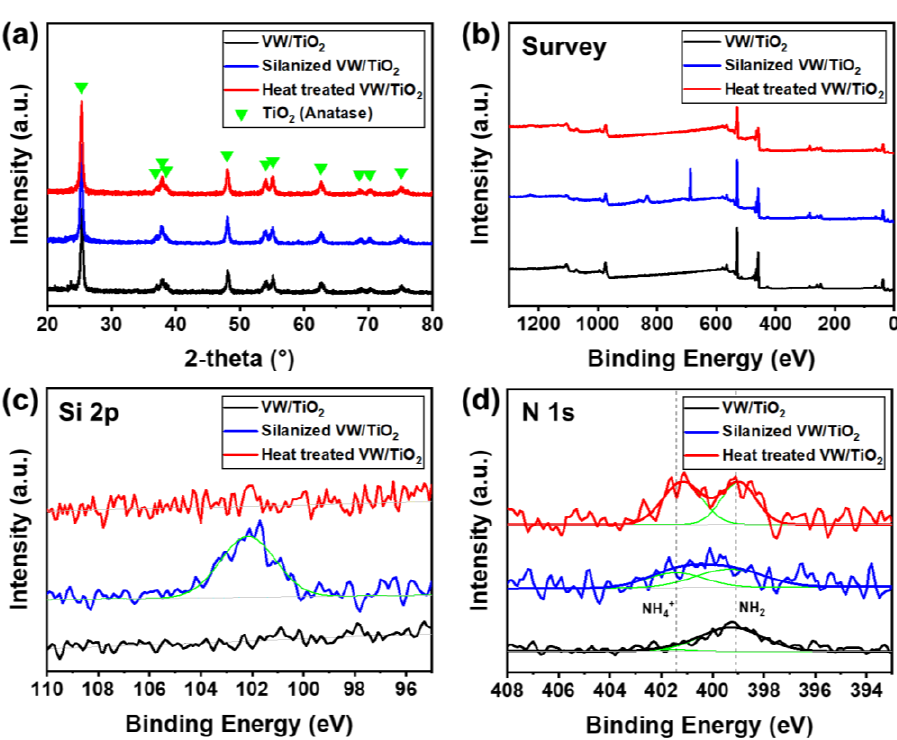
Figure 3. ( a ) XRD patterns and XPS spectra for ( b ) survey, ( c ) Si 2p, and ( d ) N 1s of V 2 O 5 -WO 3 /TiO 2 (black line), silanized V 2 O 5 -WO 3 /TiO 2 (blue line), and heat-treated V 2 O 5 -WO 3 /TiO 2 (red line). The NO X removal efficiency and N 2 selectivity following the formation of the NH 4+ layer on the surface of the V 2 O 5 -WO 3 /TiO 2 catalyst were measured in a fixed bed (Figure 4). Figure 4a shows the NO X removal efficiency of the prepared samples, which were higher for the silanized catalyst and heated silanized catalyst than for the original V 2 O 5 -WO 3 /TiO 2 catalyst below 300 ◦ C. The catalytic performance of the silanized V 2 O 5 -WO 3 /TiO 2 catalyst improved from 45% to 60%, particularly at 200 ◦ C. Figure 4b shows the N 2 selectivity; a trace amount of N 2 O in the prepared catalyst was produced at 300 ◦ C. The trend in N 2 selectivity was similar to the NO X removal efficiency, and the heat-treated V 2 O 5 -WO 3 /TiO 2 catalyst showed a higher N 2 selectivity at 420 ◦ C. Sulfur in the fuel deactivated the catalyst through the poisoning effect, specifically in the low-temperature range (below 300 ◦ C). When vanadium catalysts are exposed to SO x , ammonium bisulfate (NH 4 HSO 4 ) and ammonium sulfate ((NH 4 ) 2 SO 4 ) are formed on the catalyst surface, decreasing efficiency [24]. The hydrophobic properties of the coated silane prevent the formation of ammonium sulfate on the V 2 O 5 -WO 3 /TiO 2 catalyst surface, enhancing the NO X removal efficiency at low temperatures. Interestingly, the NO X removal efficiency of the silanized catalyst after heat treatment was higher than that of the silanized and original catalysts. The NH 4+ NH 3 SCR, particularly in the low-temperature range. Therefore, the NH 4+ layer on the at low temperatures, specifically at 250 ◦ C, because of the higher proton conductivity and reactivity [30], whereas silane is decomposed and reacts with NH 3 at over 300 ◦ C in the reaction gas during fixed bed evaluation, and some NH 4+ is produced on the catalyst surface. Therefore, the silanized and heat-treated V 2 O 5 -WO 3 /TiO 2 catalysts show similar catalytic performances at high temperatures (>300 ◦ C). Note that there was no significant difference in the NO X removal efficiency and N 2 selectivity between V 2 O 5 -WO 3 /TiO 2 and heat-treated V 2 O 5 -WO 3 /TiO 2 without a silane coating process in the temperature range of 150–420 ◦ C (Figure S1). This results demonstrate that silane coating is a key process to prepare ammonium ion enhanced V 2 O 5 -WO 3 /TiO 2